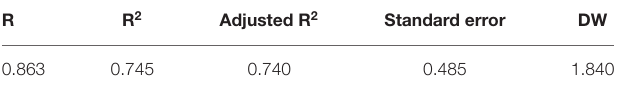
TABLE 8 | Model summary.